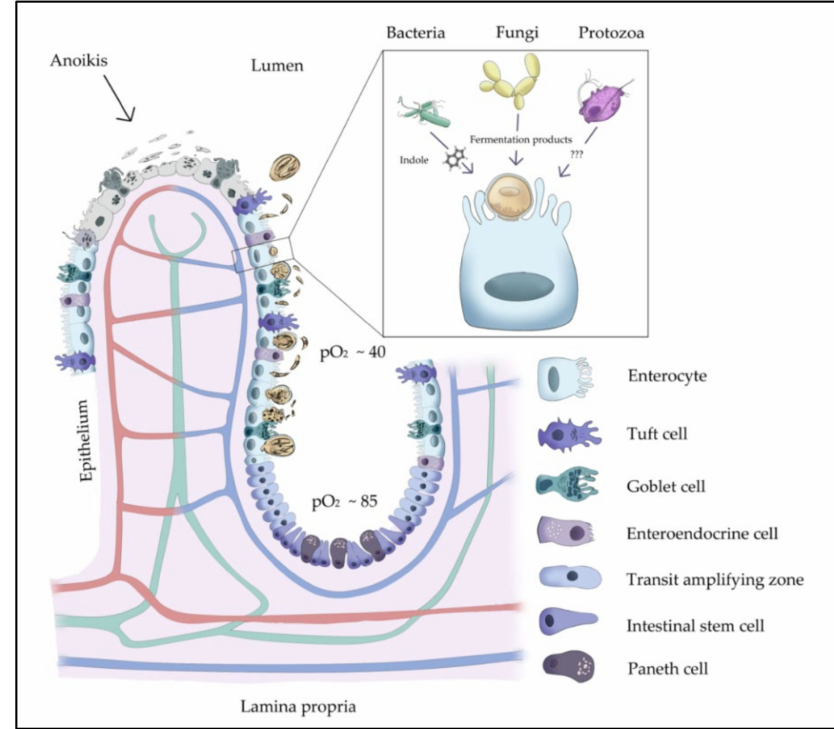
Figure 2. Illustration of possible microbiota–host epithelial cell– C. parvum interactions, with descrip- tion of diverse specialized gut cells of the small intestinal villi. It has been shown that bacteria-derived indole might act as a faecal-derived biomarker for cryptosporidiosis susceptibility in humans. In ad- dition, the faecal-bacteria-derived indole was suggested to define the metabolic interaction between bacteria and C. parvum . On the other hand, yeast-derived molecules have been proven to reduce infection-derived pathological lesions in bovines and, thus, used to ameliorate cryptosporidiosis in calves in the field. pO 2 is presented as